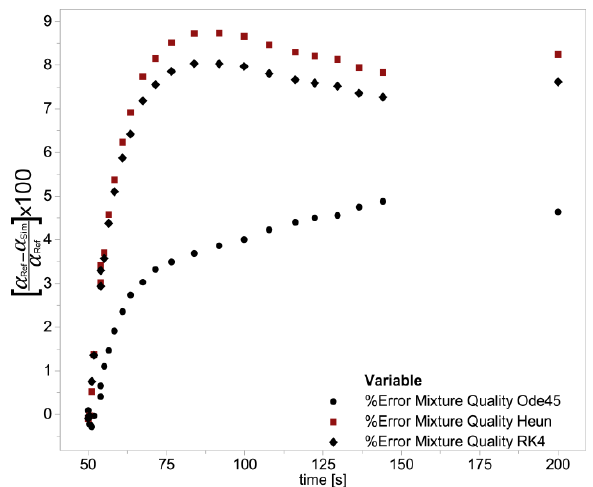
Figure 14. Approximation error for the quality of the mixture in the boiler.